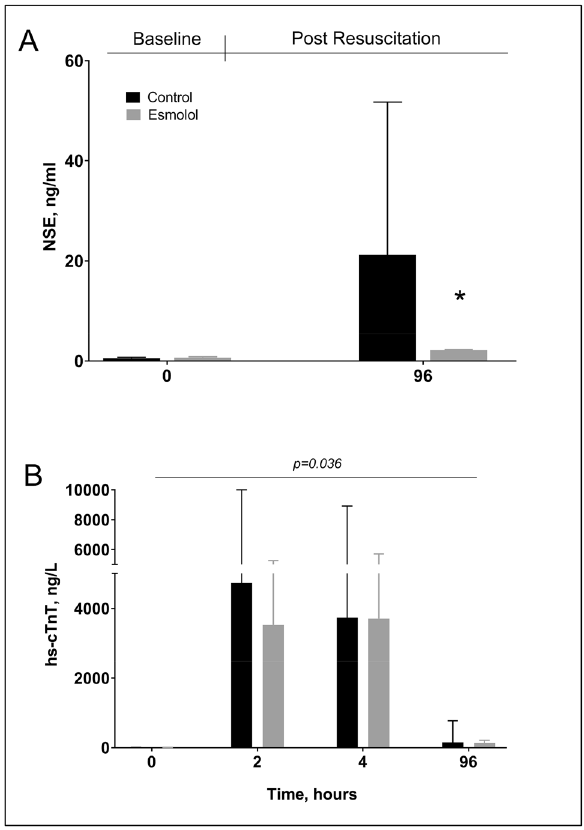
Figure 4. Serum neuronal specific enolase (NSE) levels at baseline (BL) and at 96 h after resuscitation ( A ). Plasma high-sensitive cardiac troponin T (hs-cTnT) levels at BL, 2, 4, and 96 h post-resuscitation ( B ). Data are reported as mean ± SEM. Two-way ANOVA: for NSE—treatment effect p = 0.0002, time effect p < 0.0001, interaction effect p = 0.0013; for hs-cTnT—treatment effect p = 0.036, time effect p < 0.0001, interaction effect p = 0.55. * p < 0.05 vs.